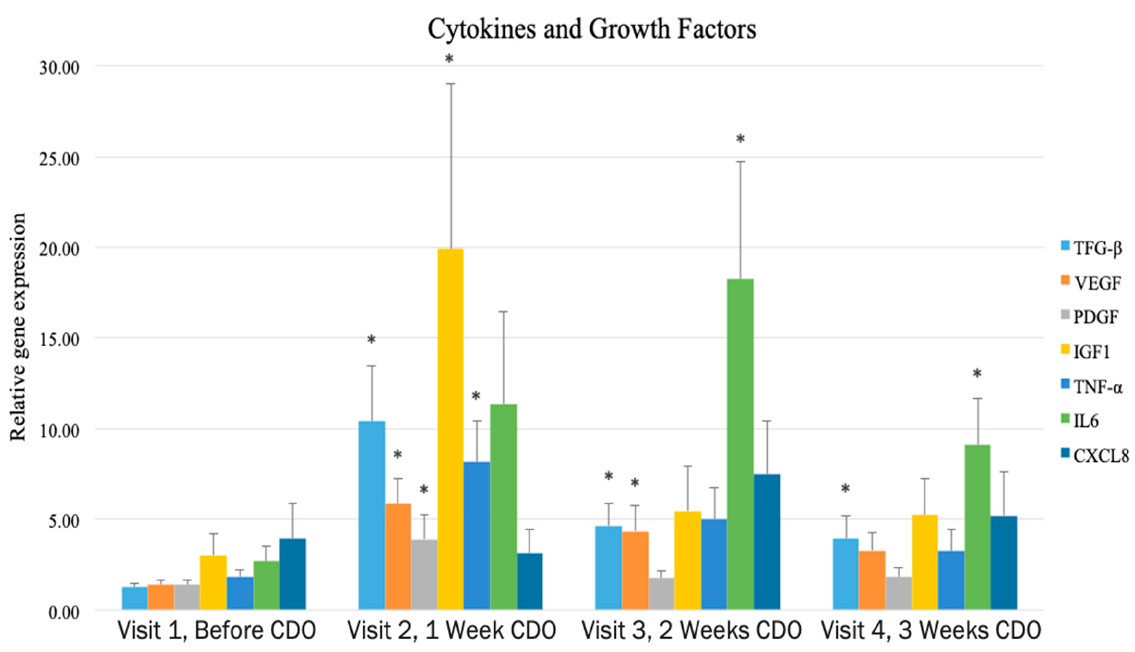
Figure 1. Impact of CDO on gene expression for various cytokines and growth factors at each visit Asterisks indicate significant increase from baseline [50]. Adapted with permission.